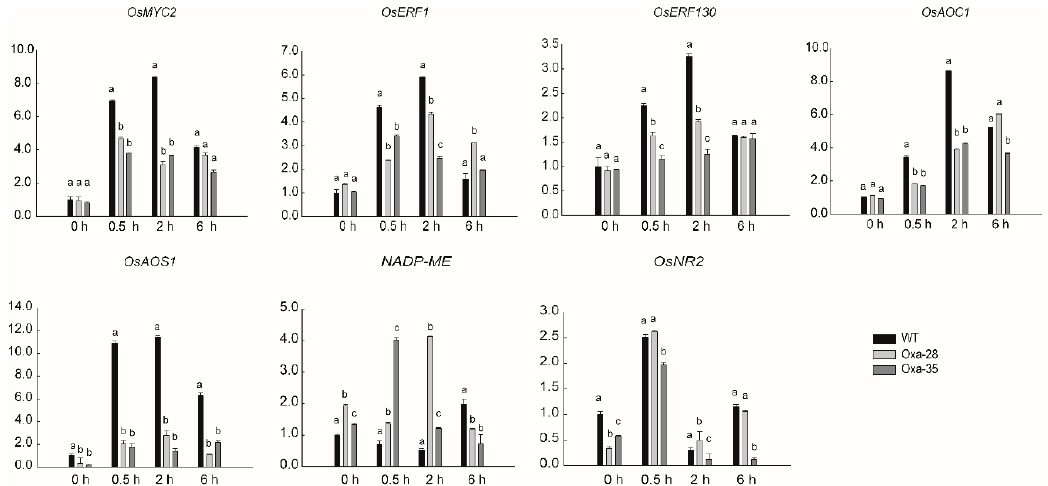
Figure 7. Expression analysis of JA-signaling-related genes in OsJAZ13a -overexpression plants treated with MeJA by qRT-PCR. RNA samples were collected at the indicated time from three-leaf-stage seedlings of wild-type and OsJAZ13a -overexpression lines treated with 100 µ M MeJA. ACTIN served as an internal control. The values are means ± SD ( n = 3 replicates). Di ff erent lowercase letters indicate significant di ff erences ( p < 0.05). The y -axis represents the relative expression level. This experiment was performed for three independent biological repeats.